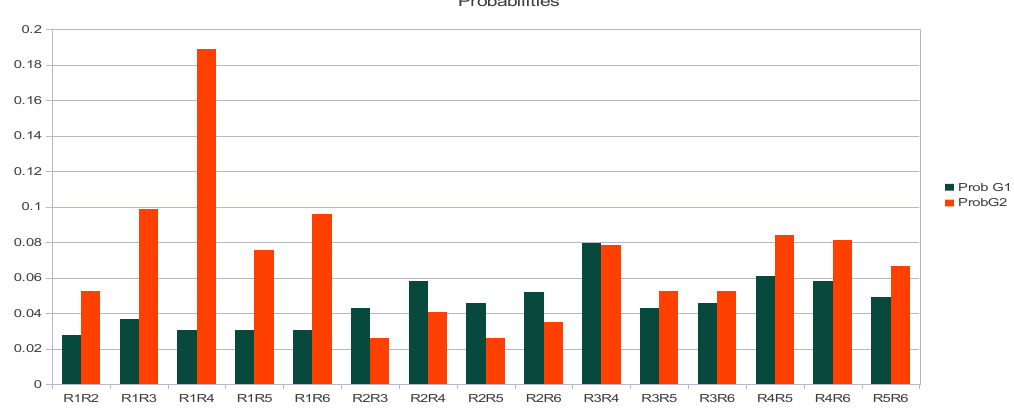
Figure 5. Probability for a variety with a genotype DSI ‐ PASI to match a pollinizer at random in an orchard.